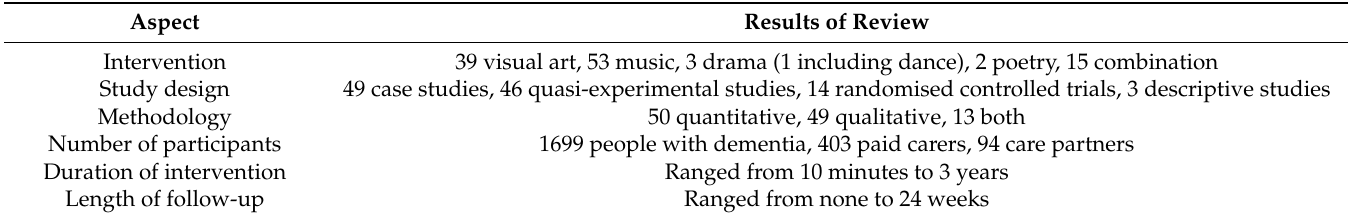
Table 1. After Cowl and Gaugler (2014), p. 286 [8].